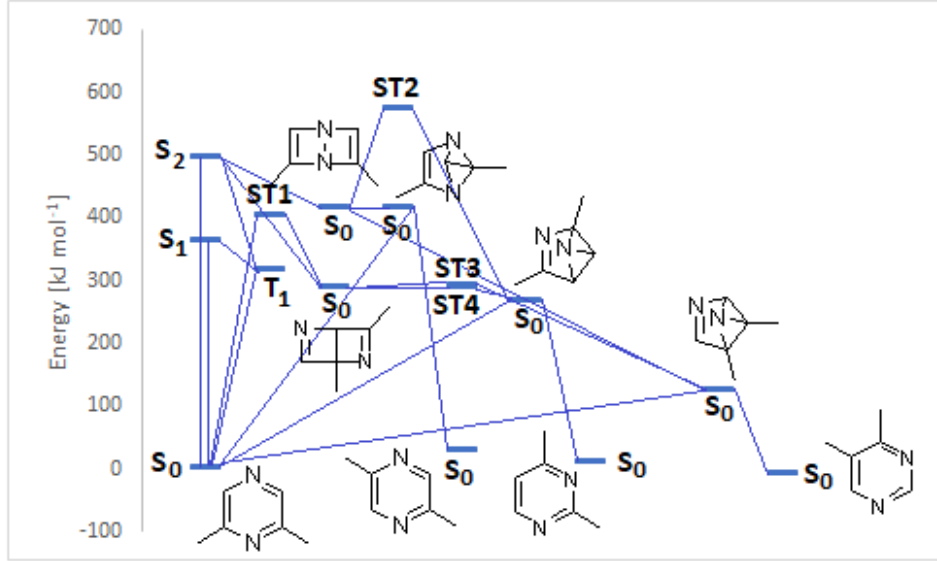
Figure 2. Photochemical isomerization of 2,6-dimethylpyrazine. Table 1. Total energy of the optimized structures.